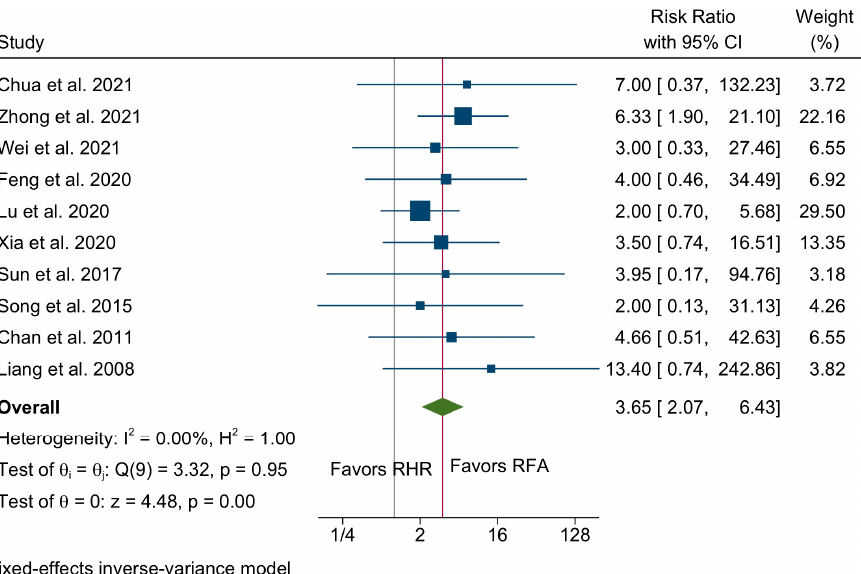
Figure 5. Forest plot of overall morbidity between the RHR and RFA groups [22,23,30,32,36]. Major (Clavien Dindo ≥ III) morbidity was assessed in 10 studies incorporating 1850 patients (791 in the RHR group vs. 1059 in the RFA group). Pooled results indicate signif- icantly increased major morbidity in patients undergoing RHR (RR 3.65, 95% C.I. 2.07 to